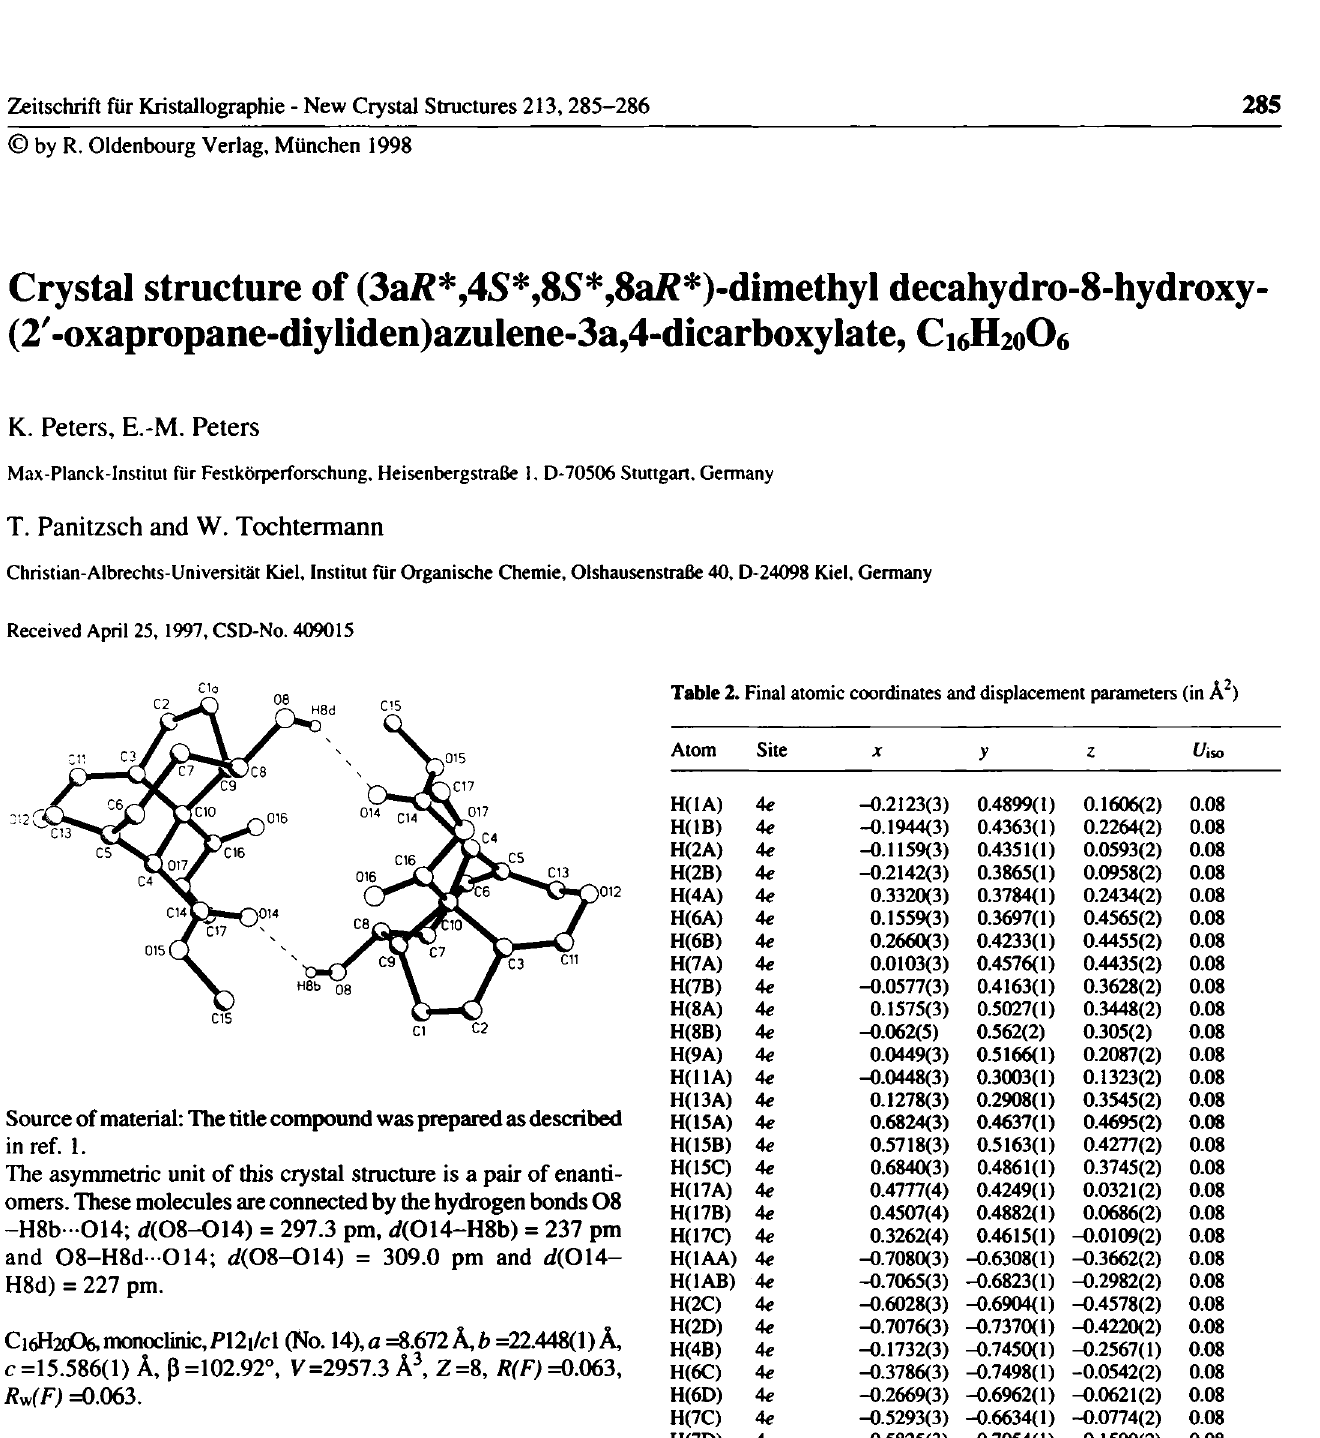
Table 1. Parameters used for the X-ray data collection Crystal: